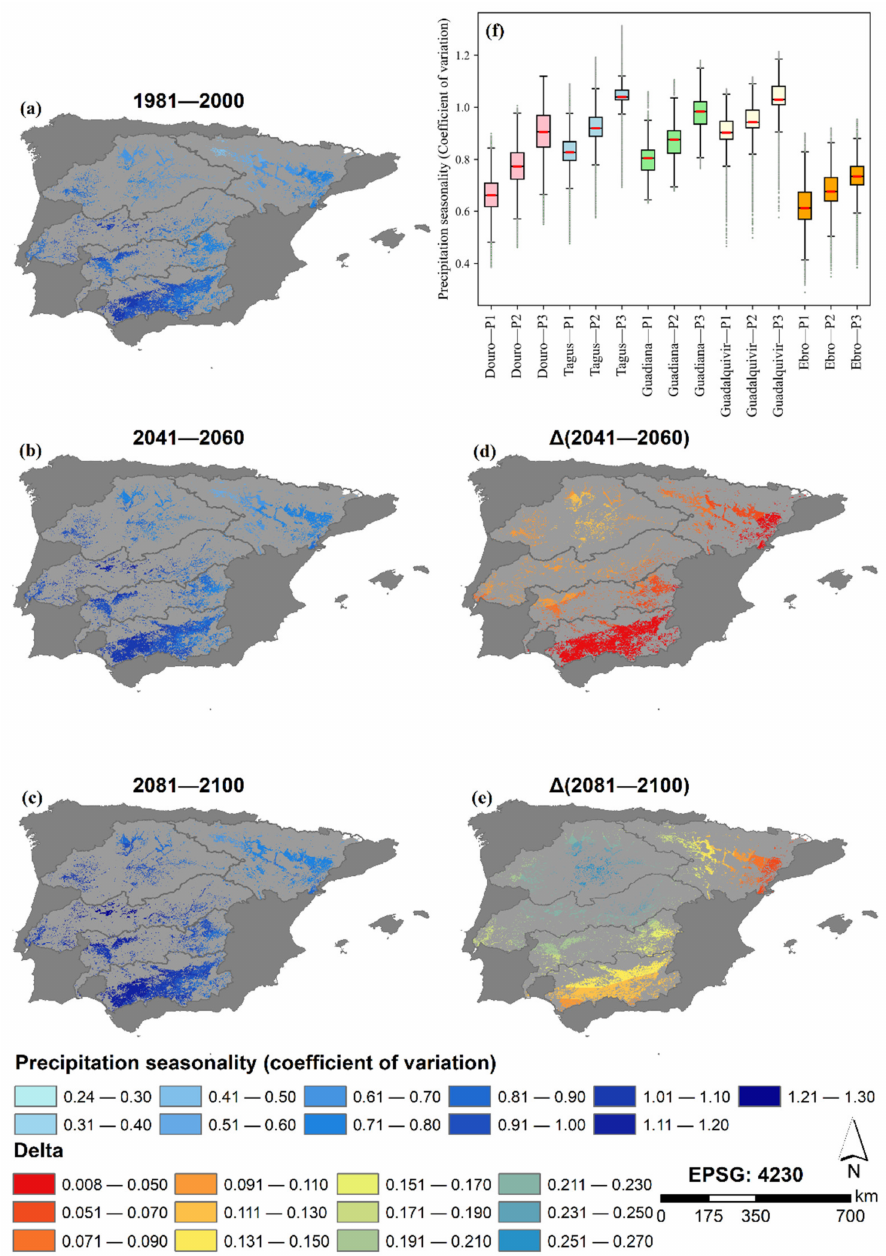
Figure 7. Precipitation seasonality in water-dependent areas in the Iberian Peninsula for: ( a ) historical period 1981–2000 (P1), ( b ) 2041–2060 (P2), and ( c ) 2081–2100 (P3), ( d ) P2–P1, ( e ) P3–P1, and ( f ) locality, spread, and skewness for each period and river